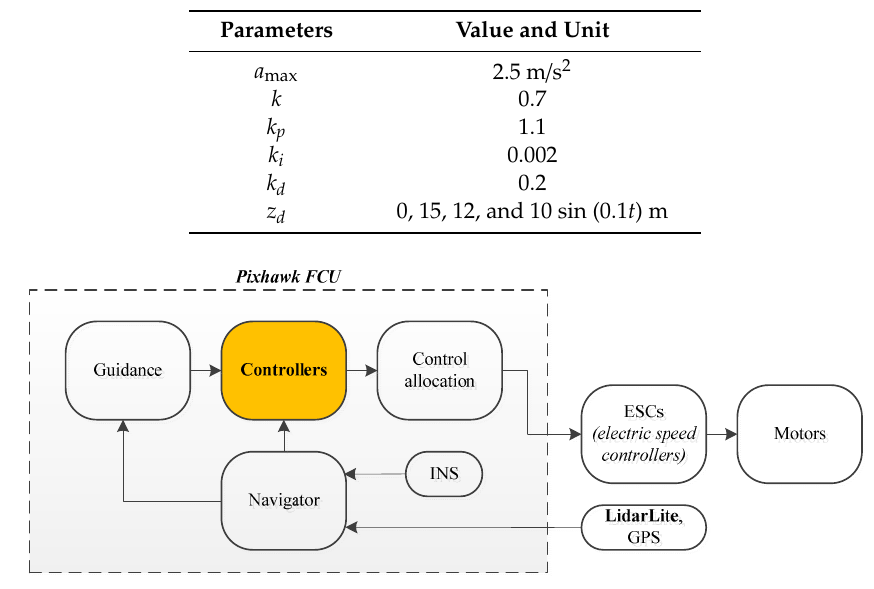
Figure 6. The system signal flow block diagram.